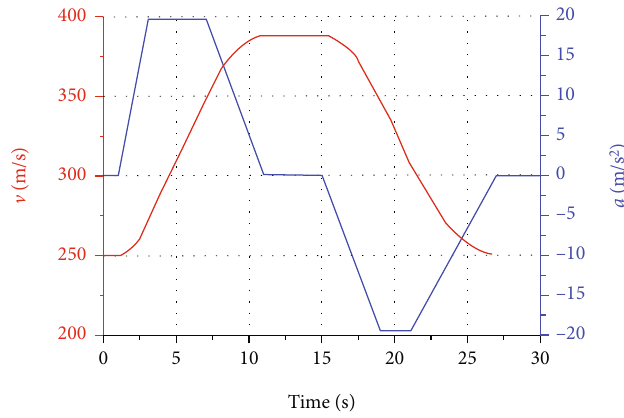
Figure 20: Aircraft speed and acceleration.